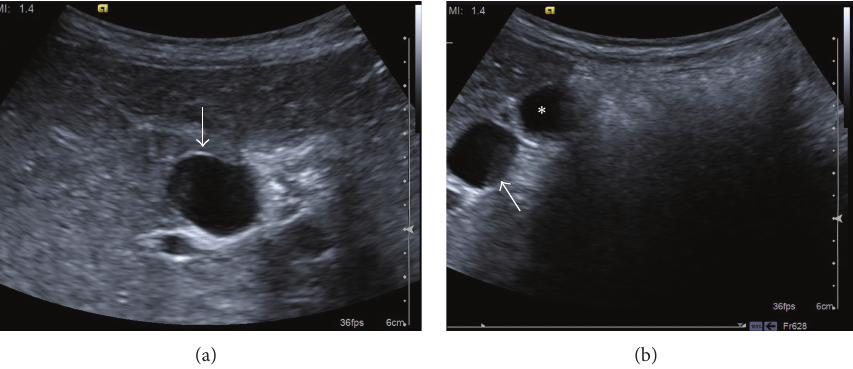
Figure 1: Ultrasound image of the cystic duct cyst: (a) the cystic duct cyst at the anterior aspect of the portal vein (white arrow); (b) the cystic duct cyst (white arrow) with the anteriorly located gall bladder